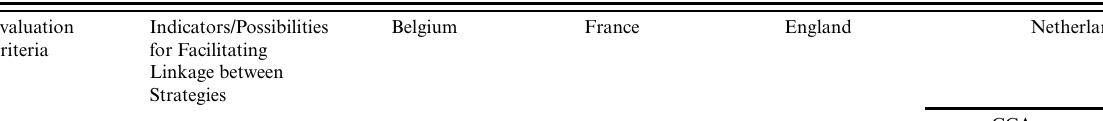
Table 3 . Evaluation of linkages in the selected